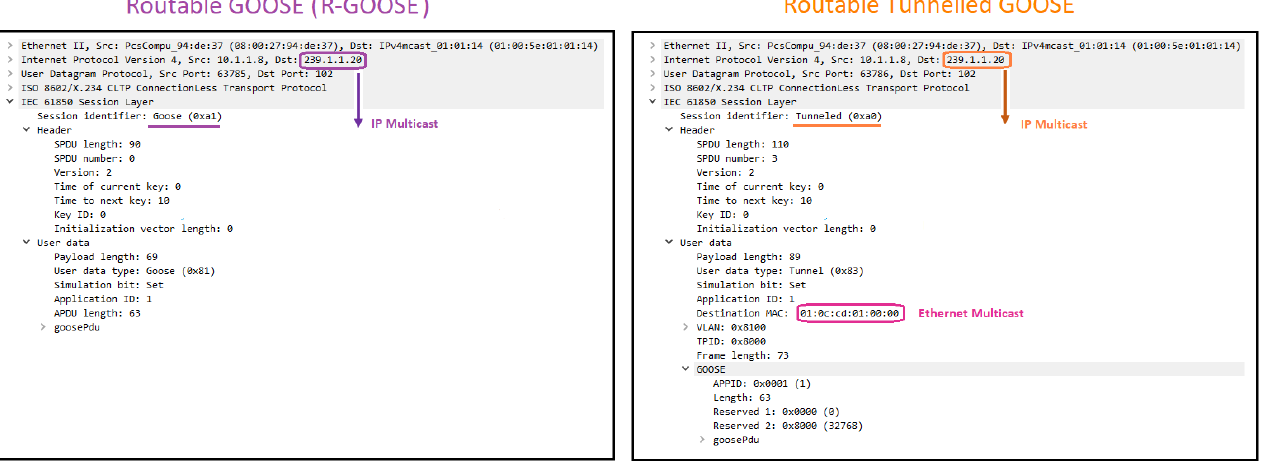
Figure 4. Routable GOOSE (R-GOOSE) vs. Routable-Tunneled GOOSE.